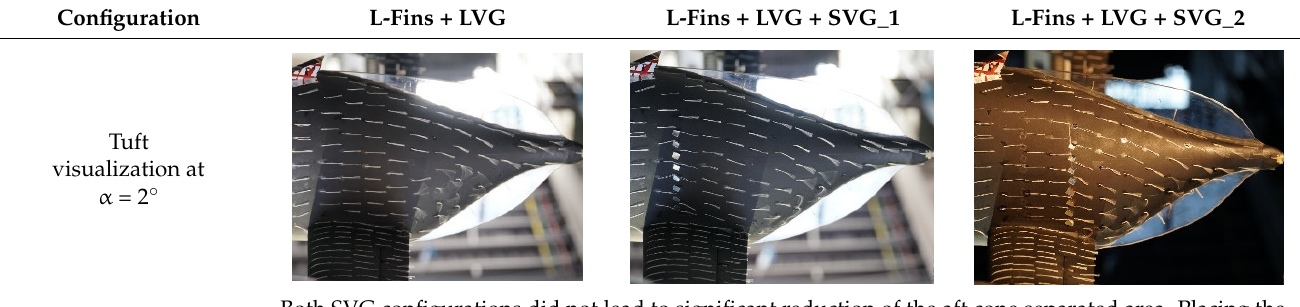
Table 5. Aft fuselage tuft flow visualization with medium VG installed in configurations 1, 2, and 3.